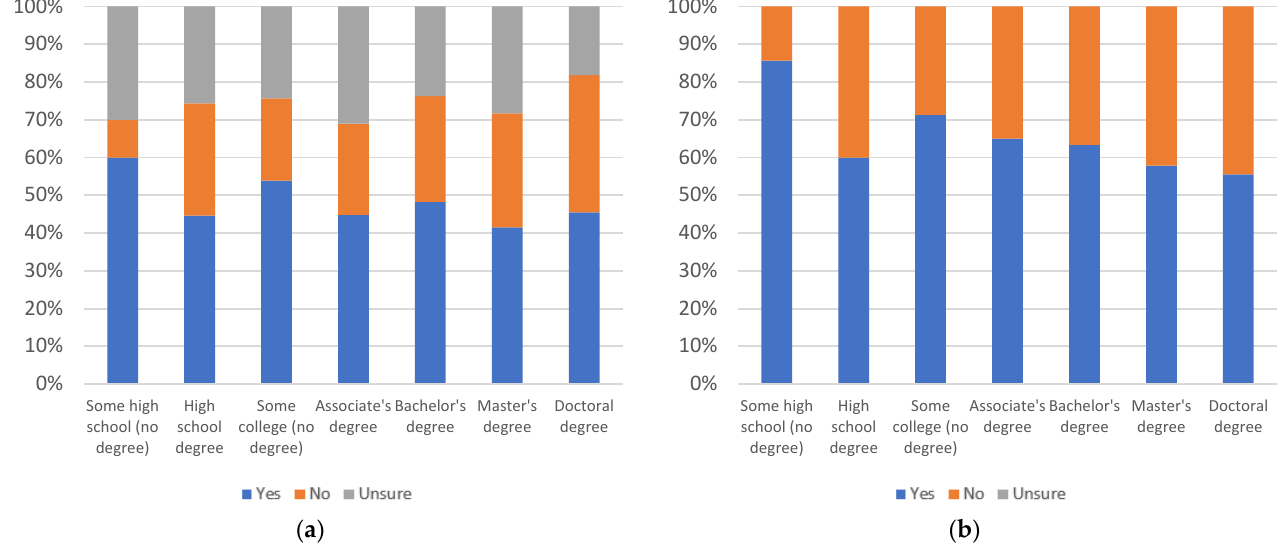
Figure 47. Label others’ use, by education level: ( a ) with uncertain respondents (left) and ( b ) without uncertain respondents (right).